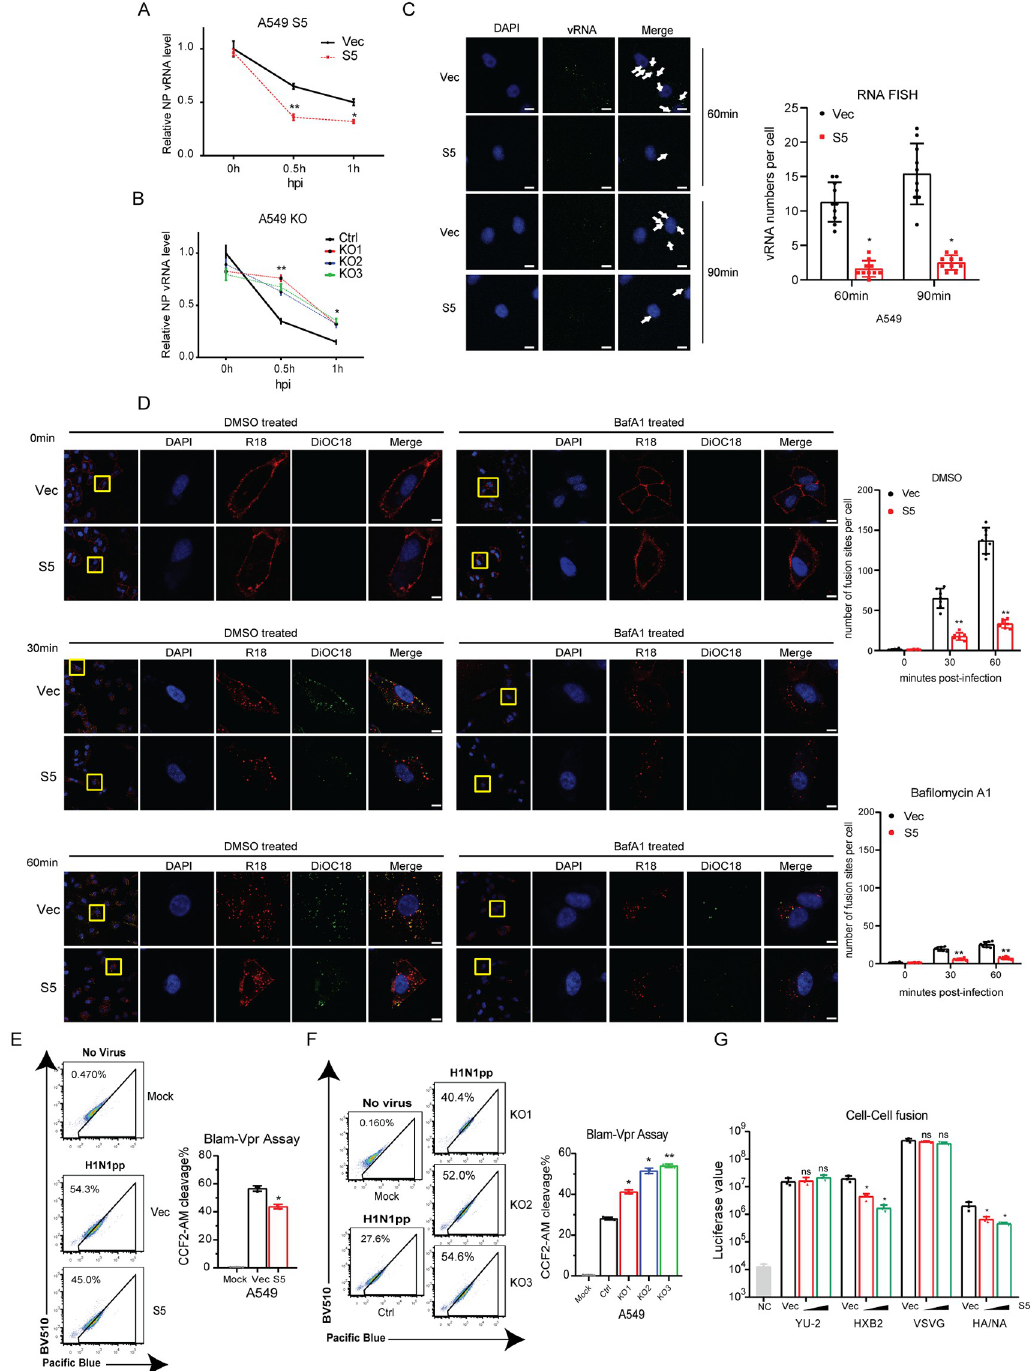
Fig 3. SERINC5 inhibits the fusion of IAV with cellular membrane. A-B: Levels of IAV NP vRNA in infected A549 SERINC5-overexpressing cells (A) or SERINC5-knockout cells (B). C: A549 cells with SERINC5 overexpression were incubated with IAV WSN (MOI = 50) for 60 min, or 90 min, then fixed and stained for nuclei (blue), PB1 vRNA (green). Scale bar, 10 μ m. Ten views were selected and vRNA numbers per cell are summarized in the graph. D: A549 SERINC5-overexpressing cells were infected with DiOC18 and R18 labled WSN (MOI = 20), cells were fixed and stained for nuclei (blue). Virus were shown in red and virus fusion were shown in green. Scale bar, 5 μ m. Seven views were selected and number of fusion sites per cell are summarized in the graph. E-F: BlaM assay to measure IAV fusion with target cells. A549 cells with SERINC5 overexpression (20ng p24 antigen) (E) or SERINC5 knockout (10ng p24 antigen) (F) were incubated with IAV WSNpp that contain